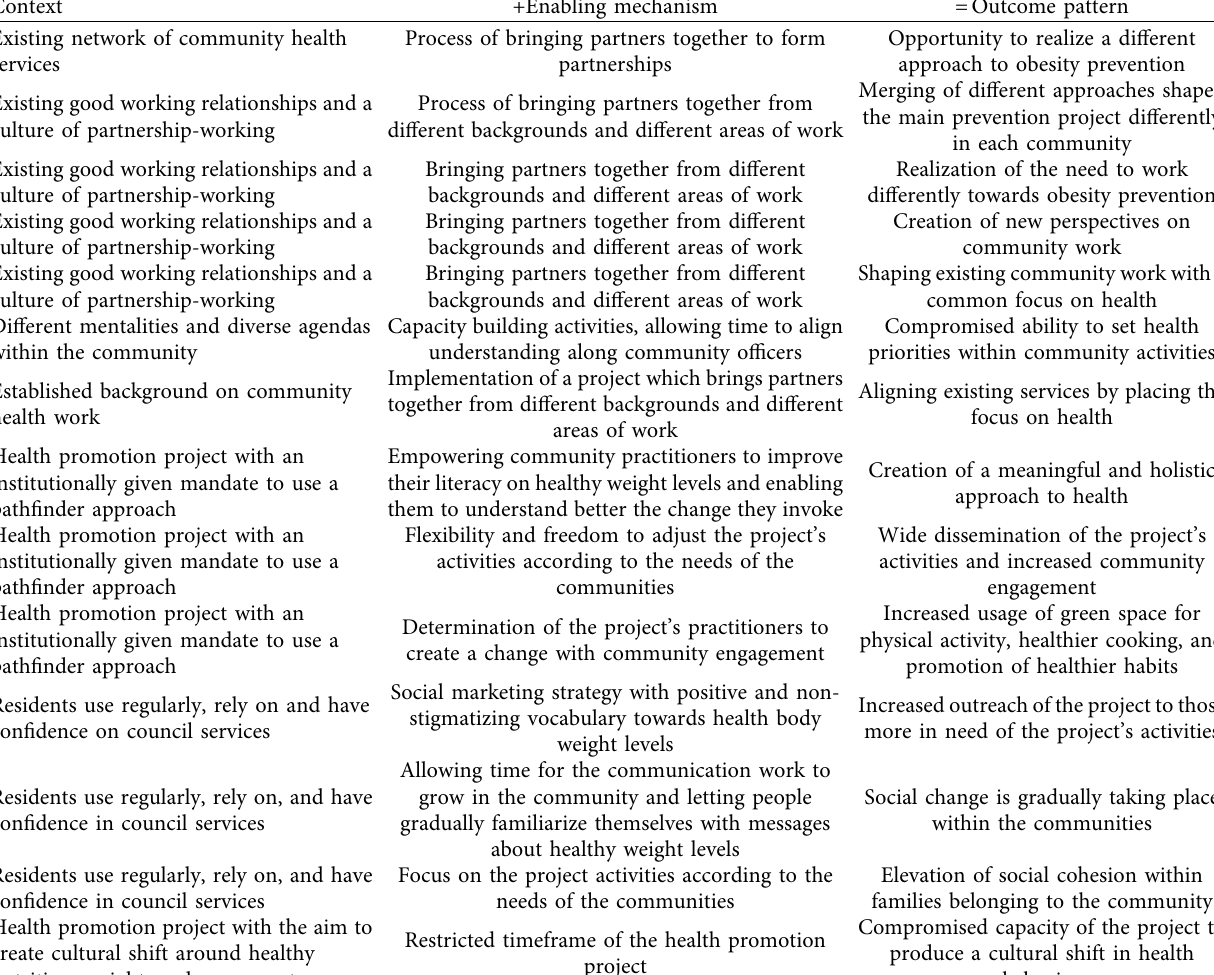
Table 2: Summary of CMO configurations in the Healthy Weight Communities (HWC)